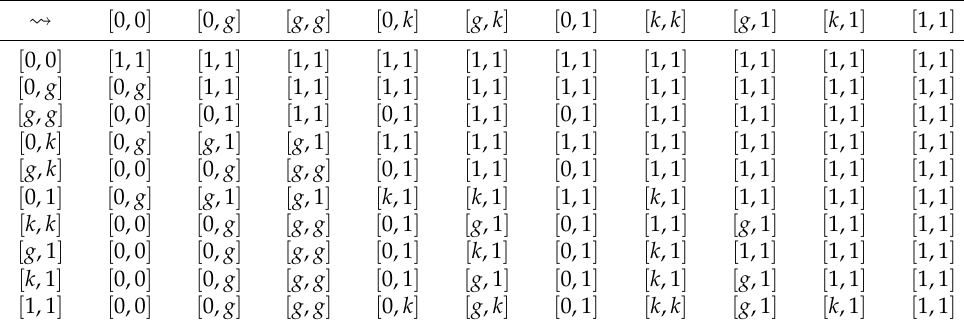
Table 6. The operator (cid:32) of algebra in Example